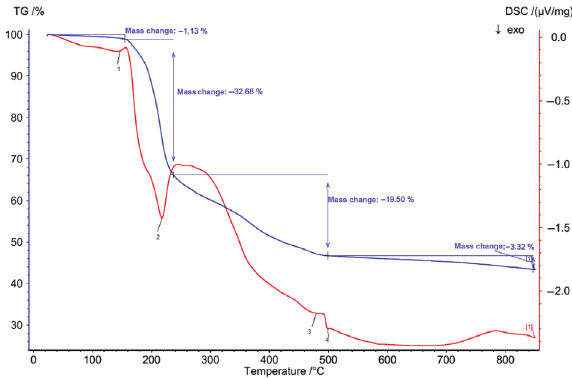
Figure 1: Thermo-gravimetric analysis (TG-DTG-DSC) for Ba 0.85 -Sm 0.1 - titanate tartrate precursor.